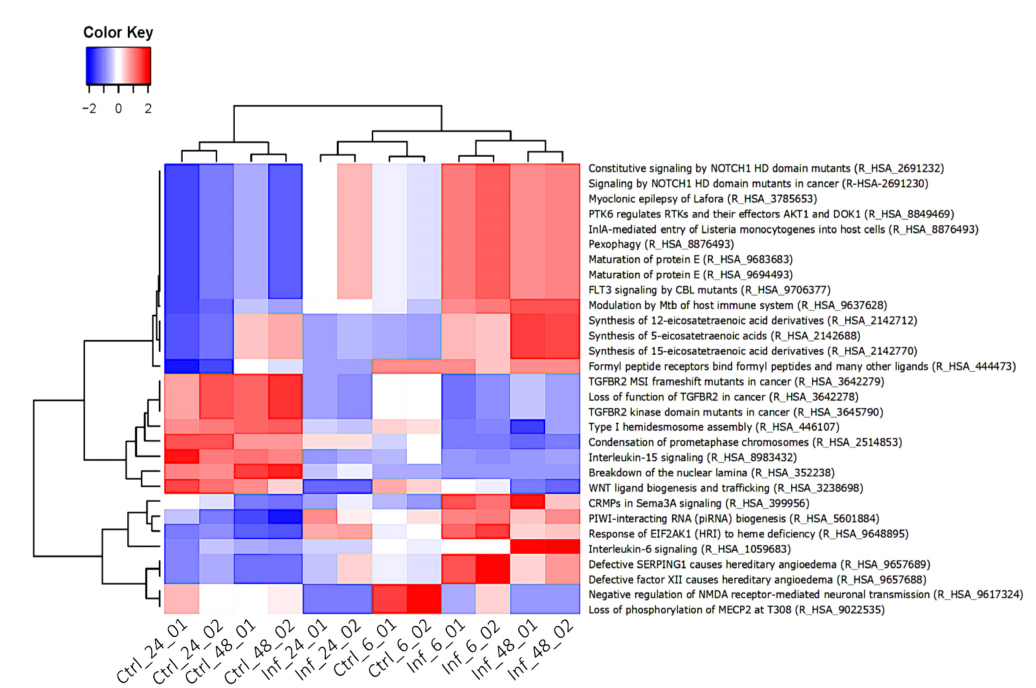
Figure 8. Heatmap clustering representing of the top 30 pathways (FDR < 0.05) in all samples. The color scale from blue (low) to red (high) corresponds to the expression values. The pathway name and Reactome pathway ID are shown on the right side of the heatmap. Columns represent the samples and time points post infection, while rows represent individual pathways. The phylogenetic tree above the heatmap shows the hierarchical clustering of the samples. The relationships between the pathways are shown on the left tree.